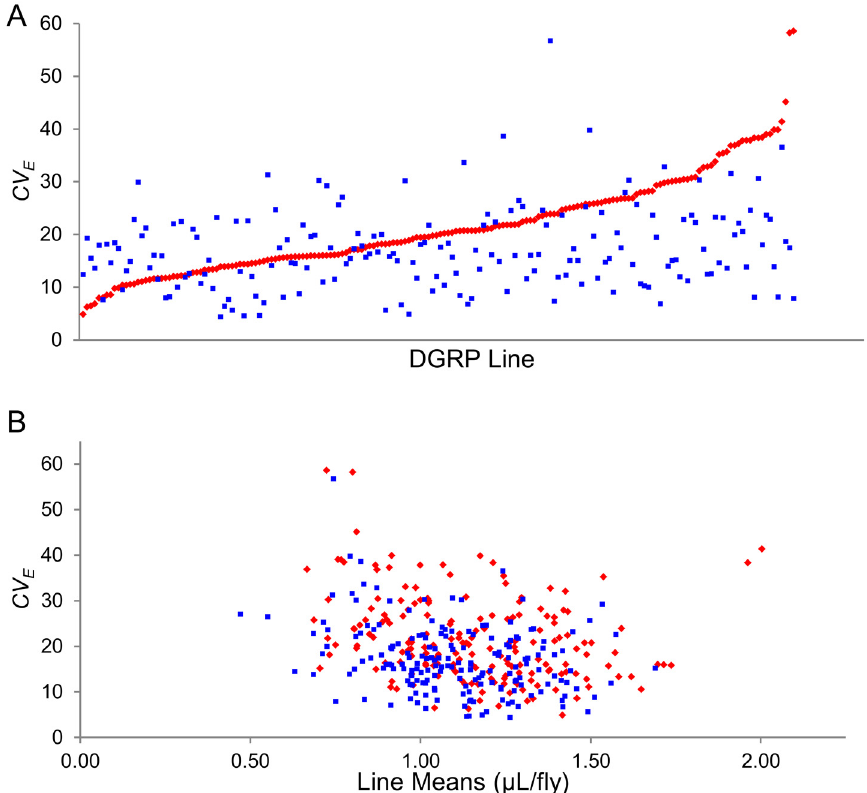
Fig 2. Variation in CV E of food intake in the DGRP. ( A ) CV E of food intake, arranged in order from lowest to highest in females (red diamonds). CV E of food intake of males (blue squares) are given in the same order as the females. ( B ) Association of mean and CV E for food intake for females (red diamonds) and males (blue